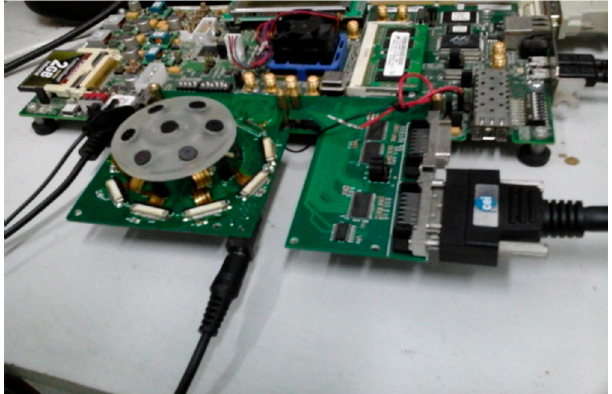
Figure 1. The multi ‐ camera system adapted to shoot images with a large field of view. Figure 1. The multi-camera system adapted to shoot images with a large field of